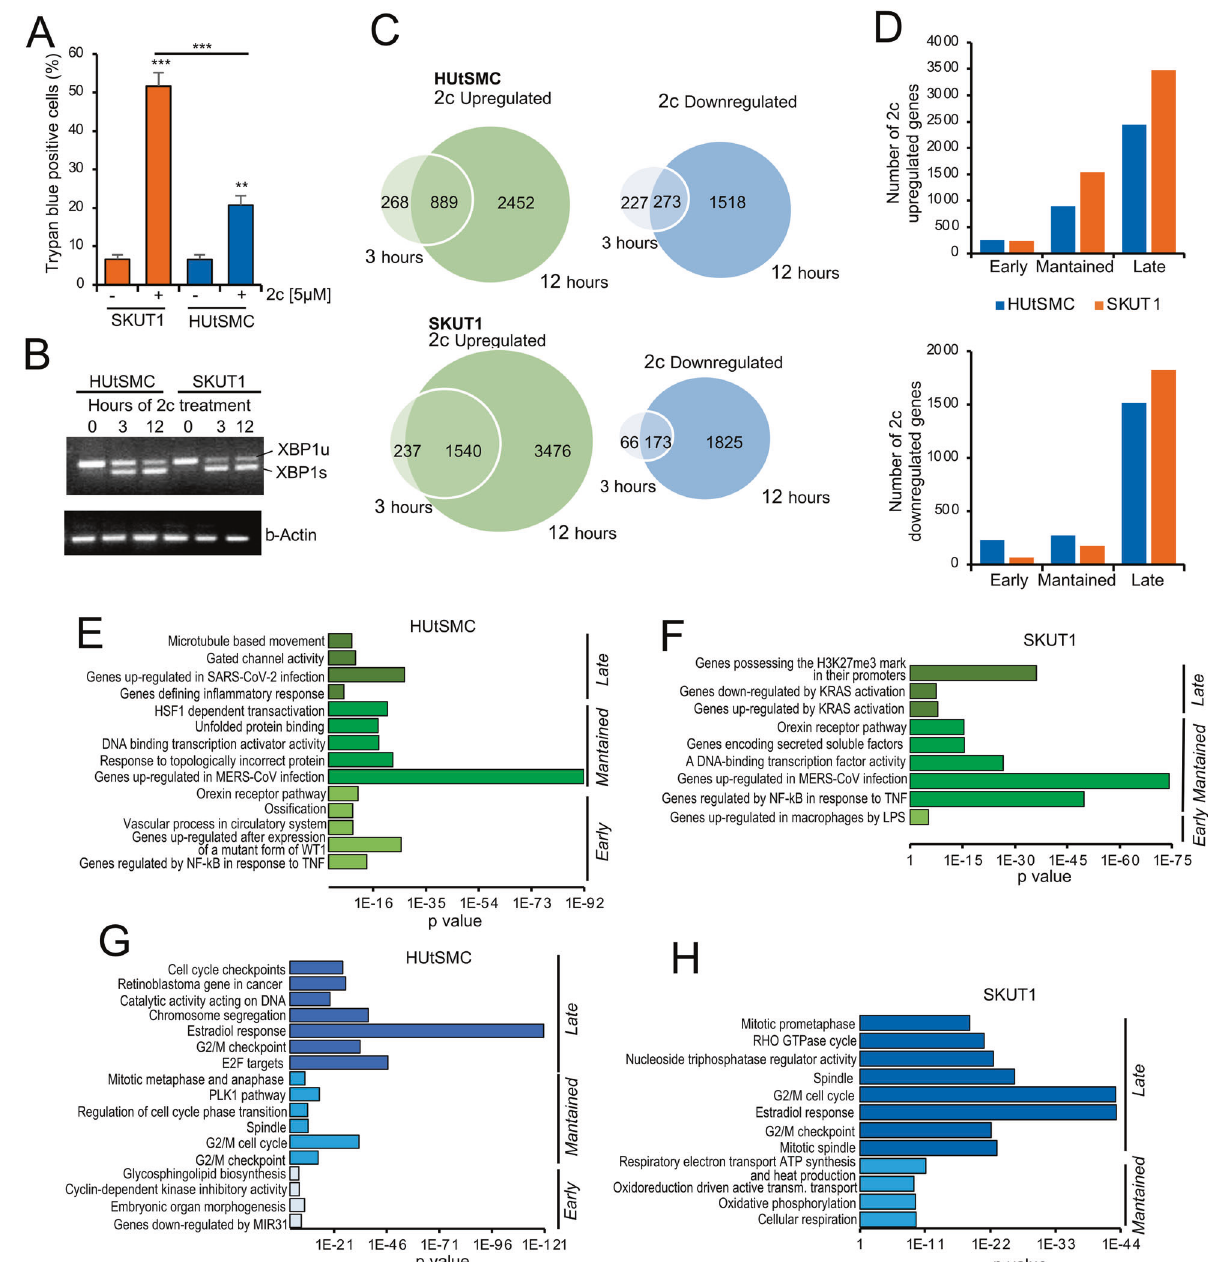
Fig. 1 Transcriptomic adaptations in normal and cancer cells during proteotoxic stress. A Cell death in SK-UT-1 and HUtSMC after 24 h of incubation with 2c. Cell death was calculated as a percentage of cells positive to Trypan blue staining. B Agarose gel electrophoresis of RT-PCR products for the full-length XBP1 transcript ( XBP1u ) and the spliced form ( XBP1s ). β -Actin was used as control. C Venn diagrams showing the number of transcripts upregulated and downregulated as indicated. 2c was used at 5 µmol/L concentration. D Total number of genes upregulated and downregulated in response to 2c-induced proteotoxic stress in HUtSMC and LMS cells only at 3 h (early genes) at both 3 and 12 ho (maintained genes) and only at 12 h (late genes). E Functional enrichments using the GSEA and the Molecular Signatures Database (MSigDB) tools. The analysis was performed for the indicated groups of upregulated genes in HUtSMC. Only the top terms are indicated. The detailed data are shown in Supplementary Table S1. F As in E , but the analysis was performed for the indicated groups of upregulated genes in SK-UT-1 cells. The detailed data are shown in Supplementary Table S1. G As in E , but the analysis was performed for the indicated groups of downregulated genes in HUtSMC. The detailed data are shown in Supplementary Table S2. H As in E , but the analysis was performed for the indicated groups of downregulated genes in SK-UT-1 cells. The detailed data are shown in Supplementary Table S2. The transcription factor X-box binding protein 1 (XBP1) is a to work with continuously cycling non-transformed cells and thus marker of ER stress and a key effector of the UPR. Activation of avoid the occurrence of senescence. Compared to LMS cells (SK- XBP1 occurs through non-conventional splicing [16]. To compare UT-1), immortalized HUtSMC-hTERT are partially resistant to cell the induction of proteotoxic stress and activation of the UPR death induced by 2c (Fig. 1A), like primary HUtSMC [5].